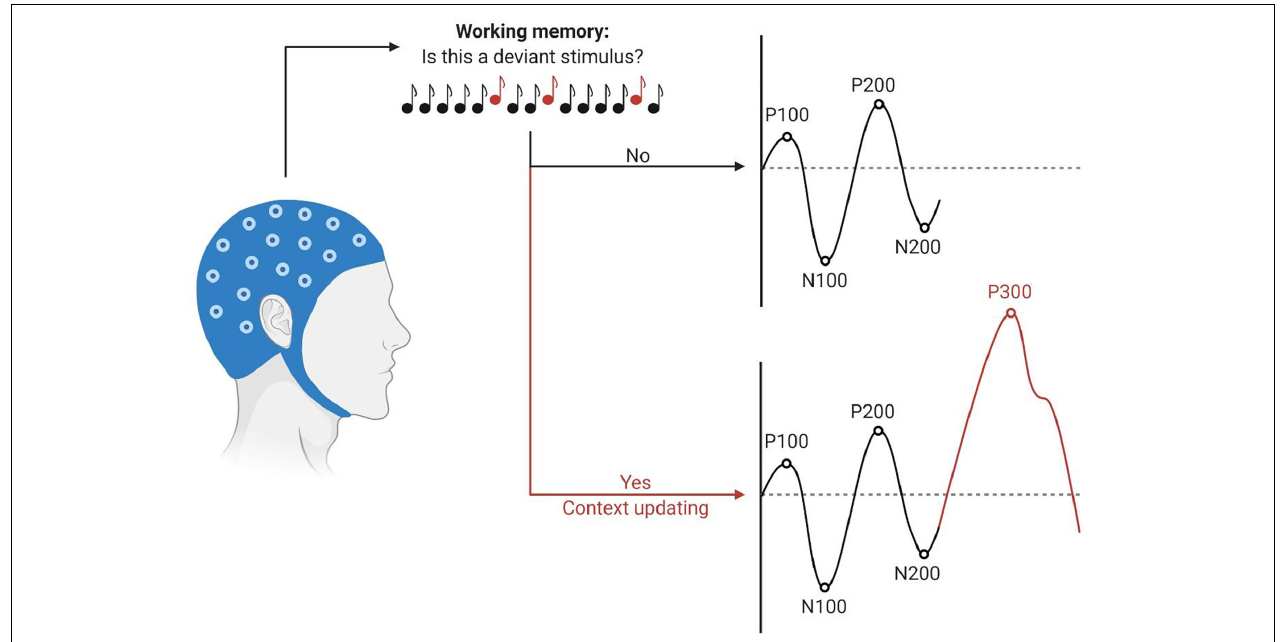
FIGURE 2 | Schematic illustration of the P300 context-updating model (Polich, 2003). Participants undergo an auditory oddball task during EEG recording. Stimuli are processed and evaluated in the working memory. If the stimulus is identical to the previous one, the mental model remains unchanged, and obligatory responses are evoked (P100, N100, P200, N200). If the stimulus deviates from the standard and participants have allocated their attention to the target stimulus, the mental model of the stimulus environment is updated. The P300 response is elicited in addition to the sensory evoked potentials. Latencies are depicted on the x -axes, amplitudes on the y -axes. This figure has been generated using BioRender R (cid:13)